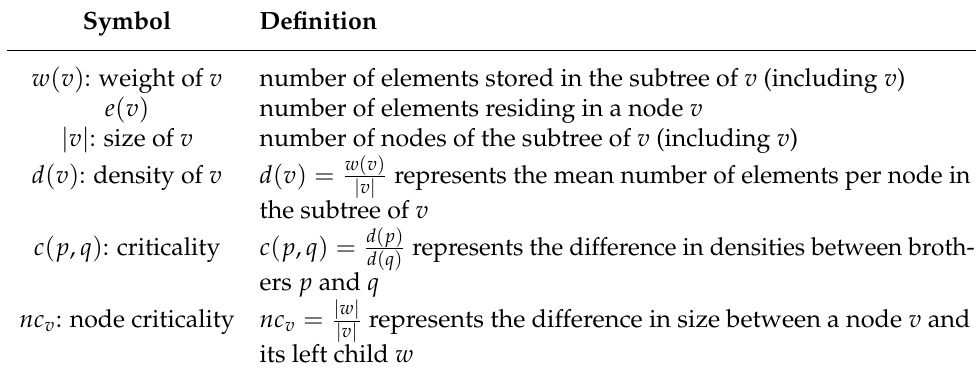
Table 2. Symbols and